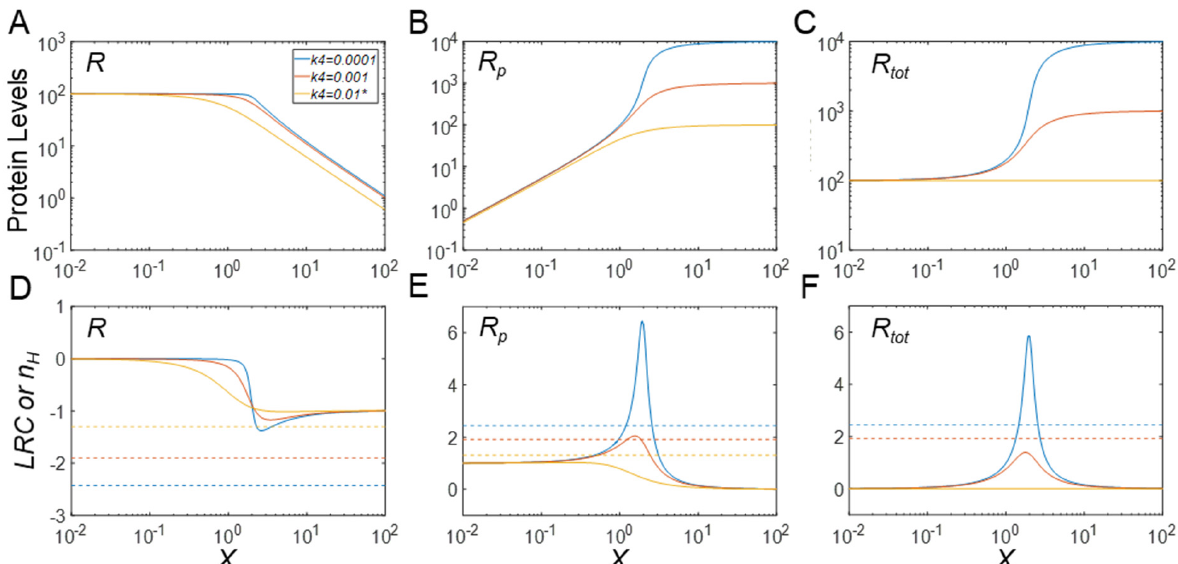
Figure 5. Emergence of ultrasensitivity through phosphorylation-induced protein stabilization in the MM model. ( A – C ) Steady-state DR curves for R vs. X , R p vs. X , and R tot vs. X , respectively, for different values of k 4 , as indicated in panel A. The same color scheme for k 4 values holds for all panels. As k 4 decreases, ultrasensitivity emerges for R p and R tot . ( D – F ) LRC (solid lines) and n H (dashed horizontal lines) for R , Rp , and R tot , respectively, for different values of k 4 . * k 4 = 0.01 is the default value. For these simulations, the Michaelis constants were set to K m 1 = K m 2 = 100.